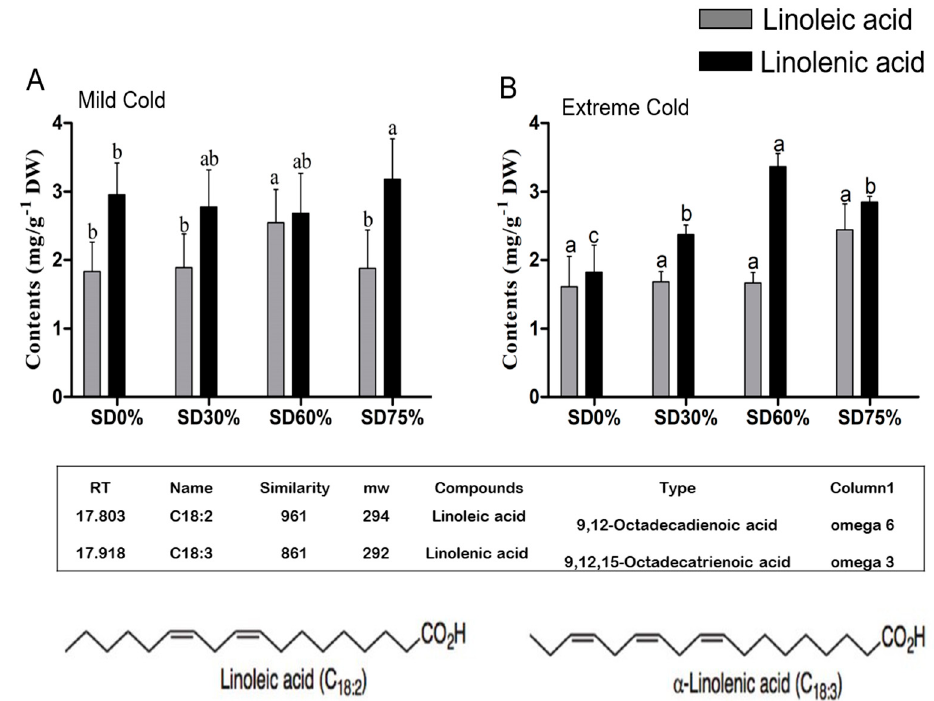
Figure 9. Effects of shading nets on ω -6 linoleic fatty acid and ω -3 alpha-linolenic acid fatty acid composition of tea during ( A ) mild cold and ( B ) extreme cold conditions. Different letters on the top of the columns within each figure represent significant differences between the treatments indicated by LSD test at p < 0.05.